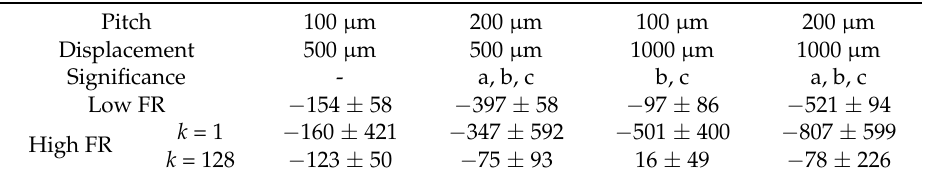
Table 3. Lateral estimation errors of the set displacement given as the mean estimation error ± one standard deviation.